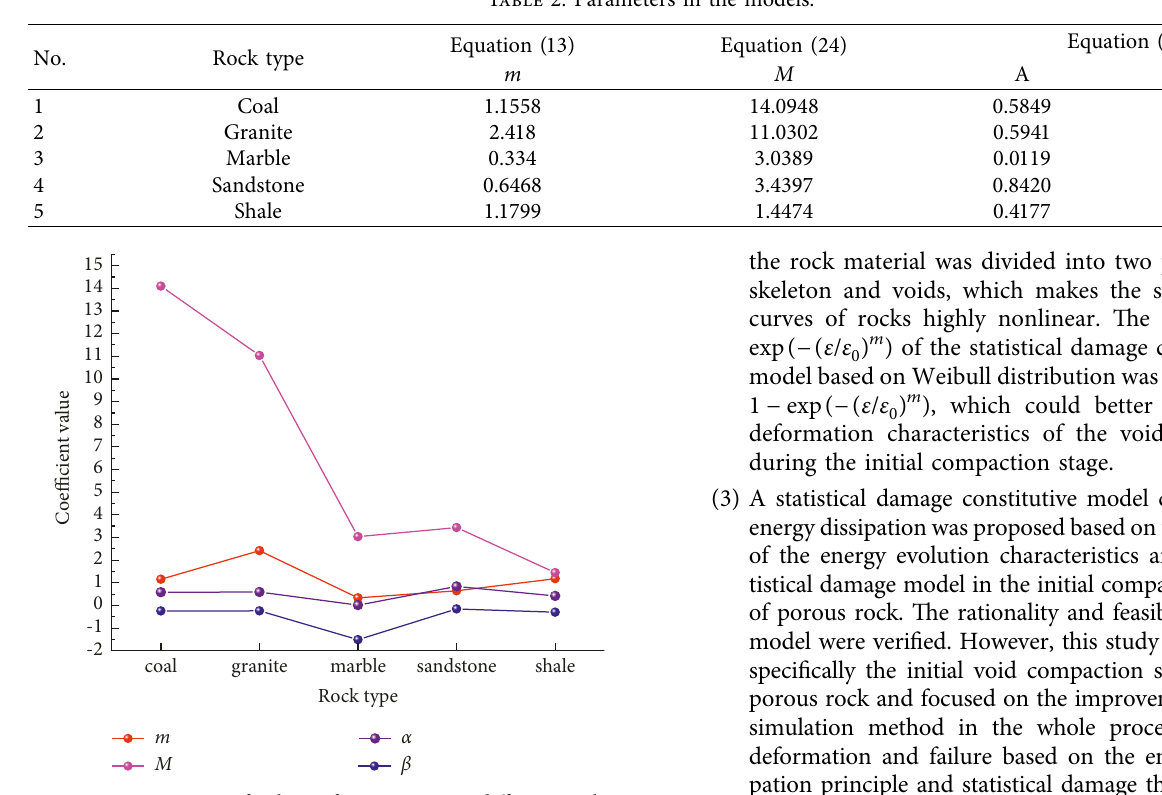
Table 2: Parameters in the models.